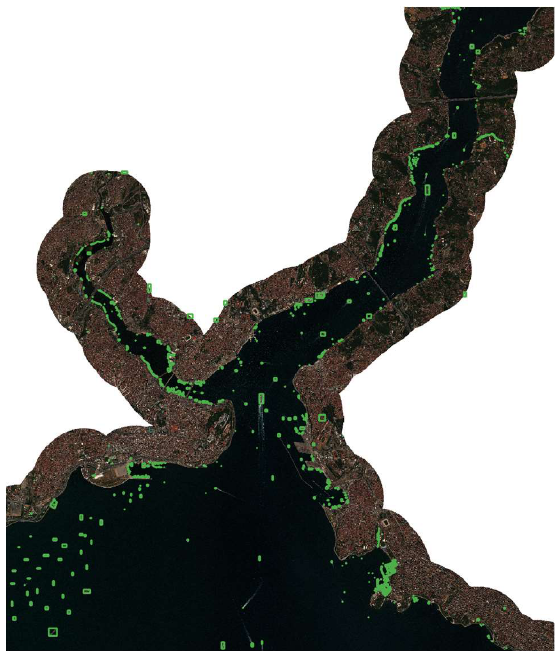
Figure 4. Panoptic view of the vessel detection result in the Istanbul AOI. Bounding boxes for the detected vessels are displayed in